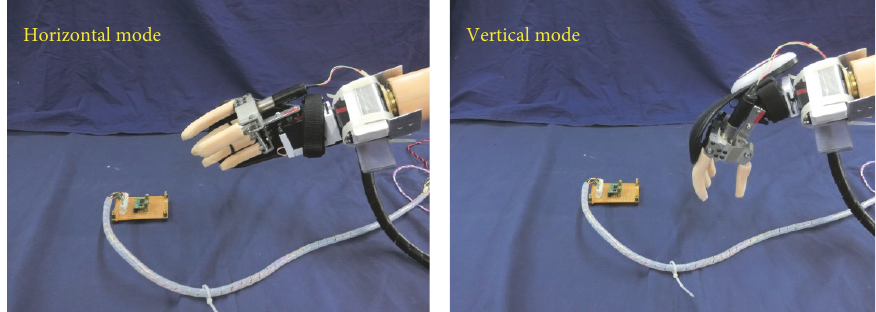
Figure 3: Horizontal mode and vertical mode of the wrist joint tracking control.